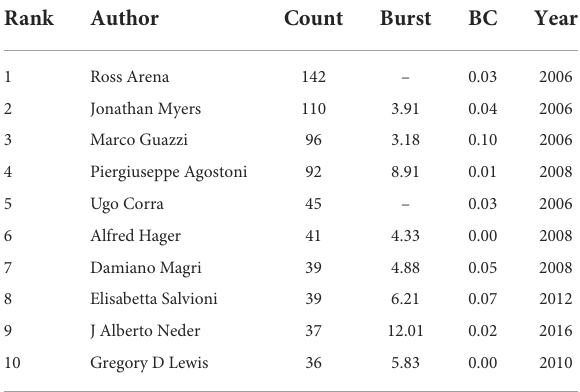
TABLE 3 Top 10 authors based on the number of CPET publications.